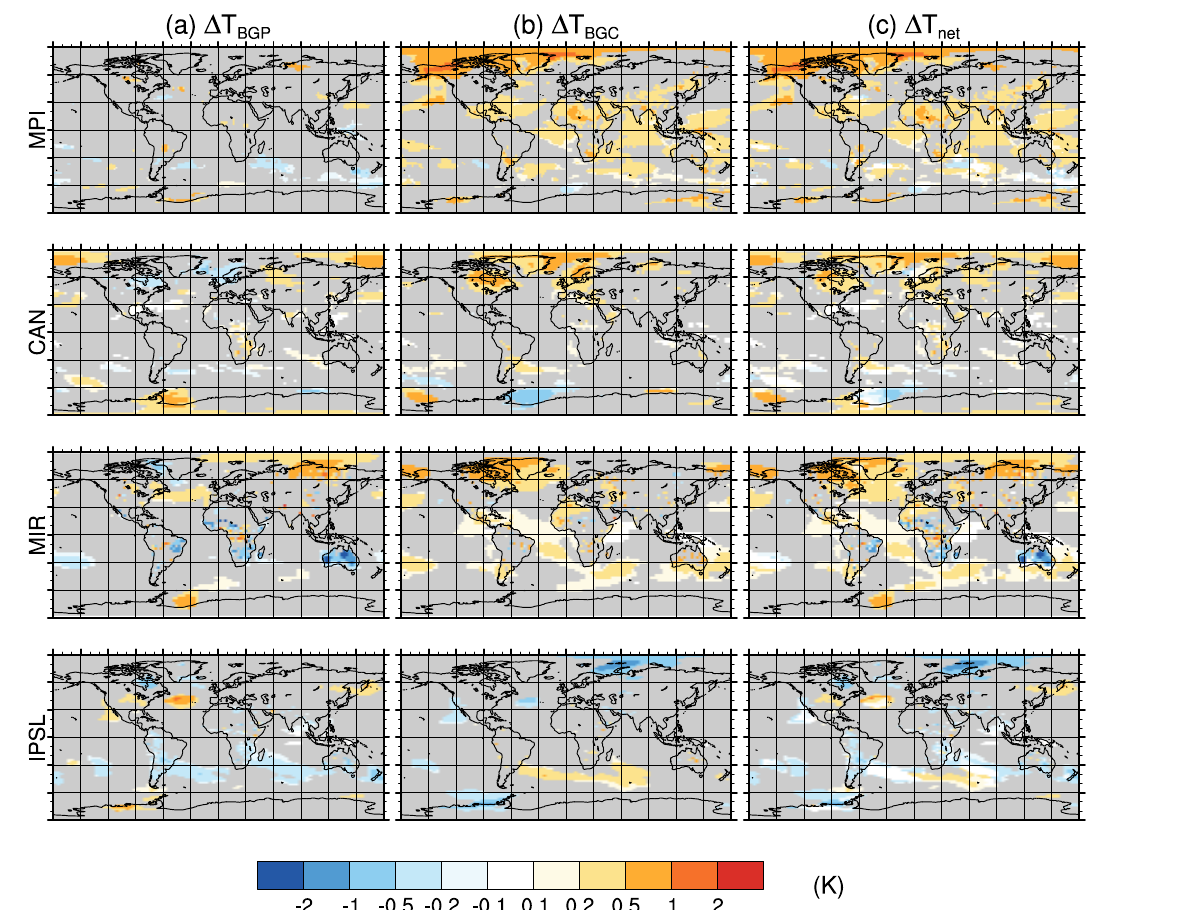
Figure 1. Maps displaying the change in near-surface temperature (K) averaged over 2071–2100 for each model. Only areas are shown where changes are statistically significant; (a) 1T BGP (for CAN 1T RCP